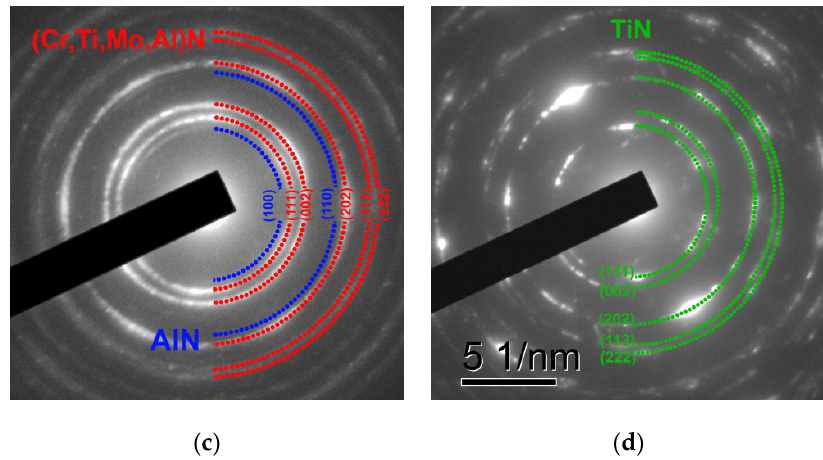
Figure 2. ( a , b ) TEM micrograph of coating and ( c , d ) SAED patterns of the coatings: ( a , c ) Ti-TiN- (Ti,Cr,Mo,Al)N and ( b , d ) (Ti,Al)N monolayer coating (TEM).